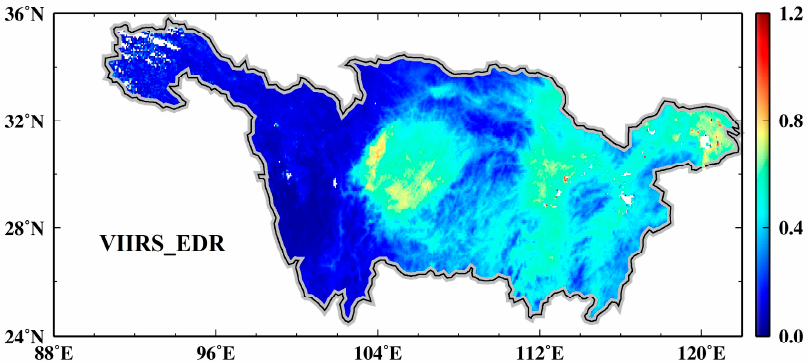
Figure 13. Spatial distribution of the annual high-quality VIIRS_EDR AOD retrievals (QF = 3) over the YRB for the period of 2 May 2012–31 December 2016. The color scale refers to AOD values.